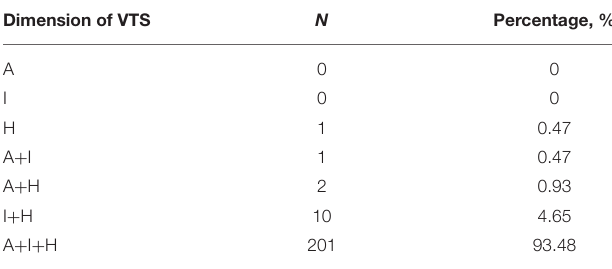
TABLE 2 | Distribution of symptoms among respondents with suspected vicarious traumatization.